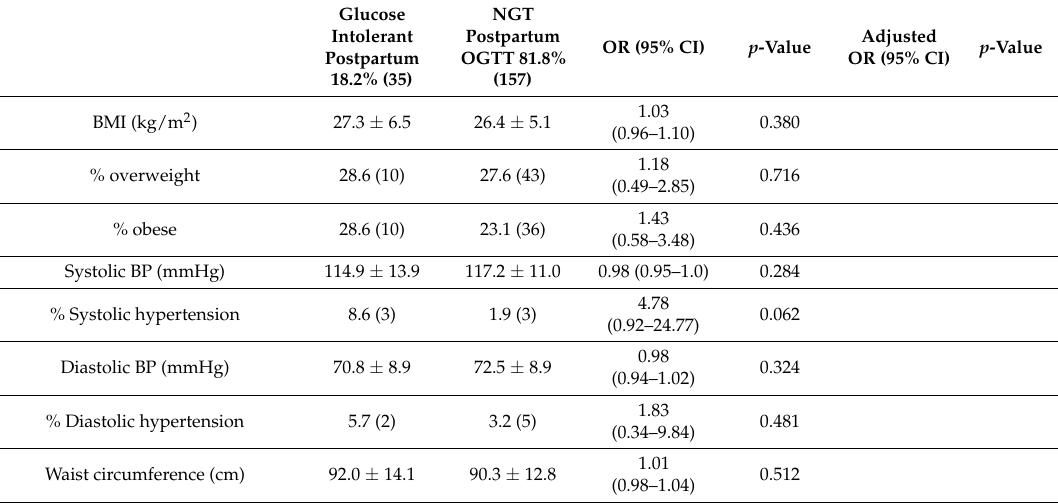
Table 3. Predictors of glucose intolerance postpartum based on clinical and biochemical risk factors 6–16 weeks of